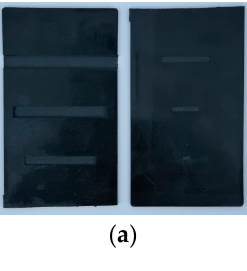
Figure 4. Schematic of the polypropylene composite sample considering various defect conditions, ( a , b ) according to composite defect (group 1); ( c , d ) according to length (group 2); ( e , f ) according to width (group 3); ( g , h ) according to depth (group 4). Table 3. Details of thermographic raw data to be processed by HA.